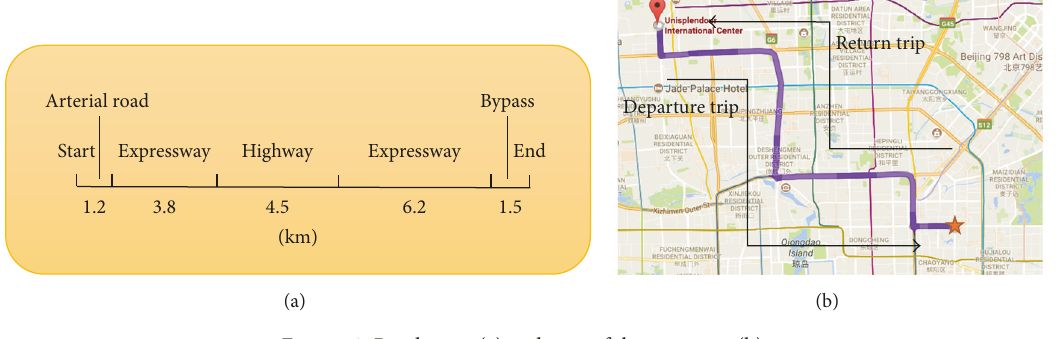
Figure 2: Road types (a) and map of the test route (b).